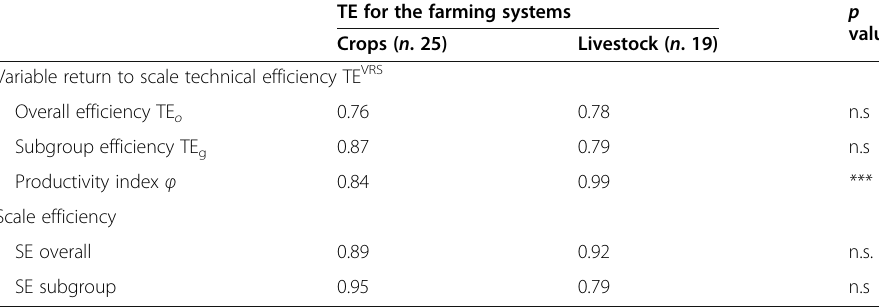
Table 4 Estimation of TE by data envelopment analysis (DEA) TE for the farming systems